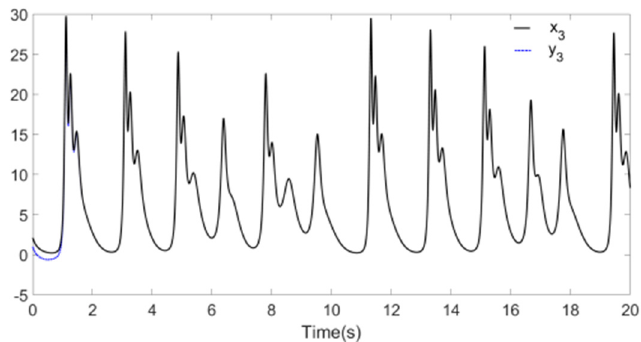
Figure 9. Synchronization of x 2 and y 2 .